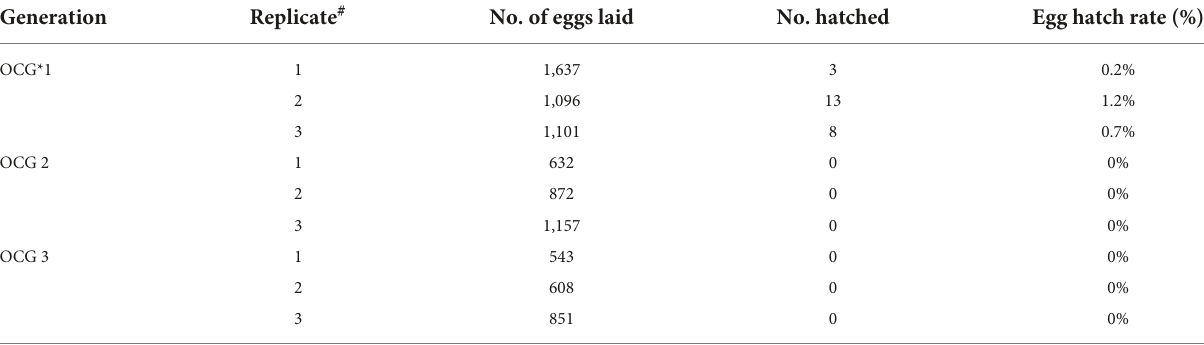
TABLE 3 Induced cytoplasmic incompatibility observed in crosses between uninfected wild Ae. aegypti (Pud) females and w Mel-infected Ae. aegypti (Pud) males. Generation Replicate # No. of eggs